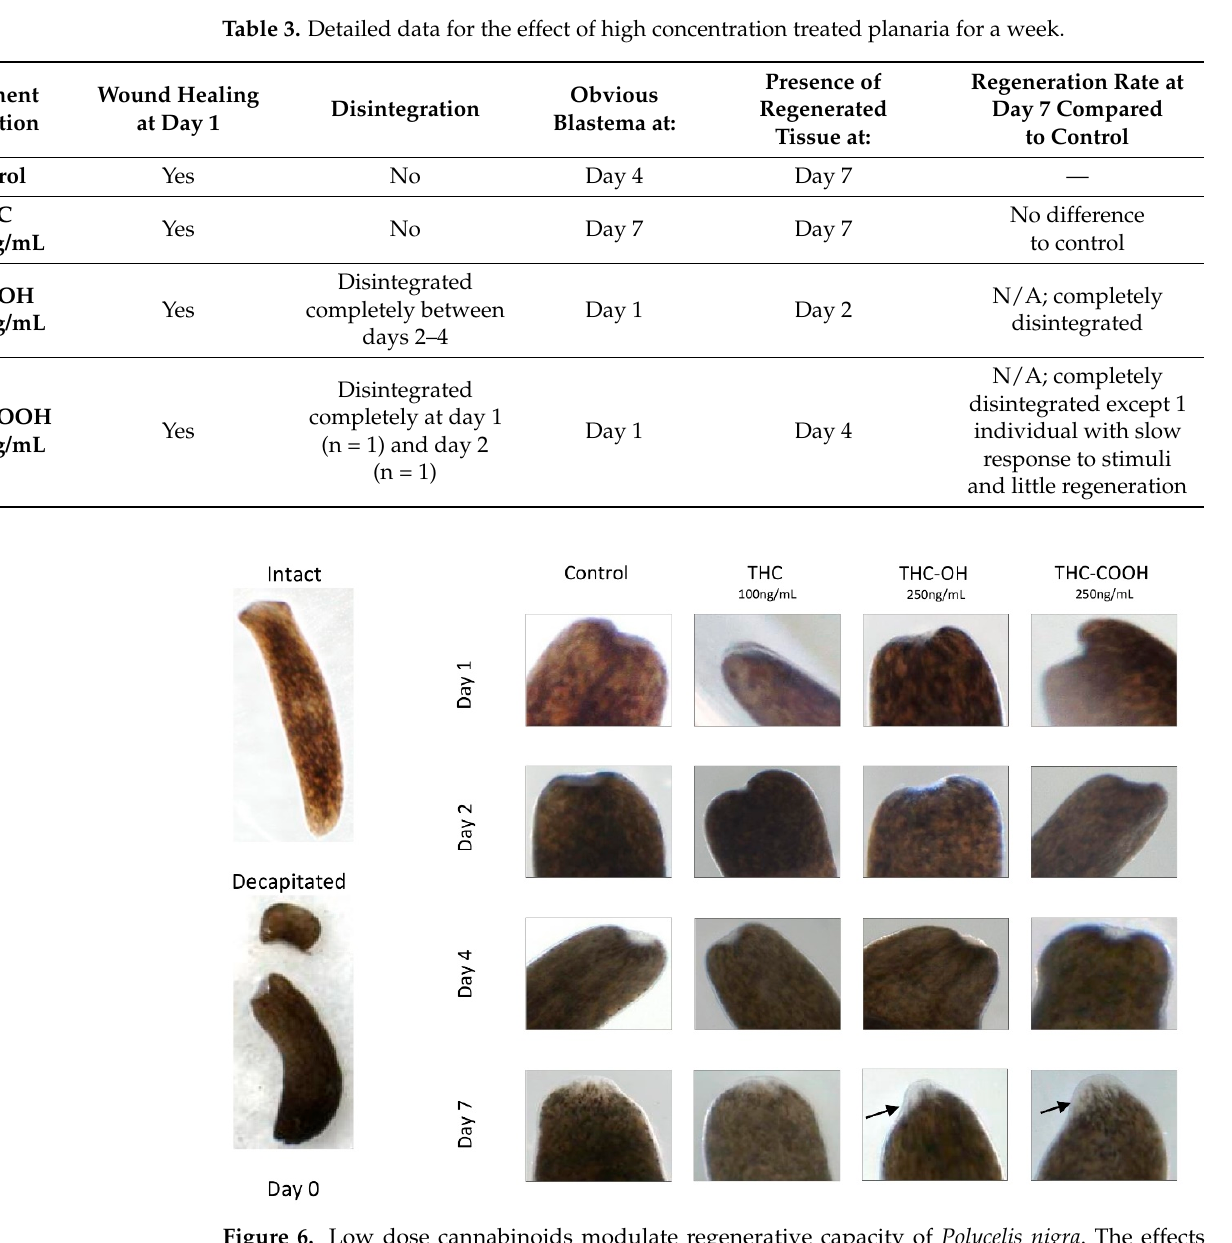
Figure 6. Low dose cannabinoids modulate regenerative capacity of Polycelis nigra . The effects of cannabinoids at low doses on the planarian flatworm regenerative capacity was assessed over 7 days. Decapitated planaria were treated with THC (100 ng/mL), THC-OH and THC-COOH (both 250 ng/mL) for one week after decapitation Arrows show increased regenerating areas. Table 2. Treatment with THC (100 ng/mL) resulted in no overall change in structure or regeneration compared to control. Conversely, increased cellular deposition was observed on the transection wound sites in response to 250 ng/mL doses of THC-OH and THC-COOH (shown in Figure 6). N = 3 per condition.